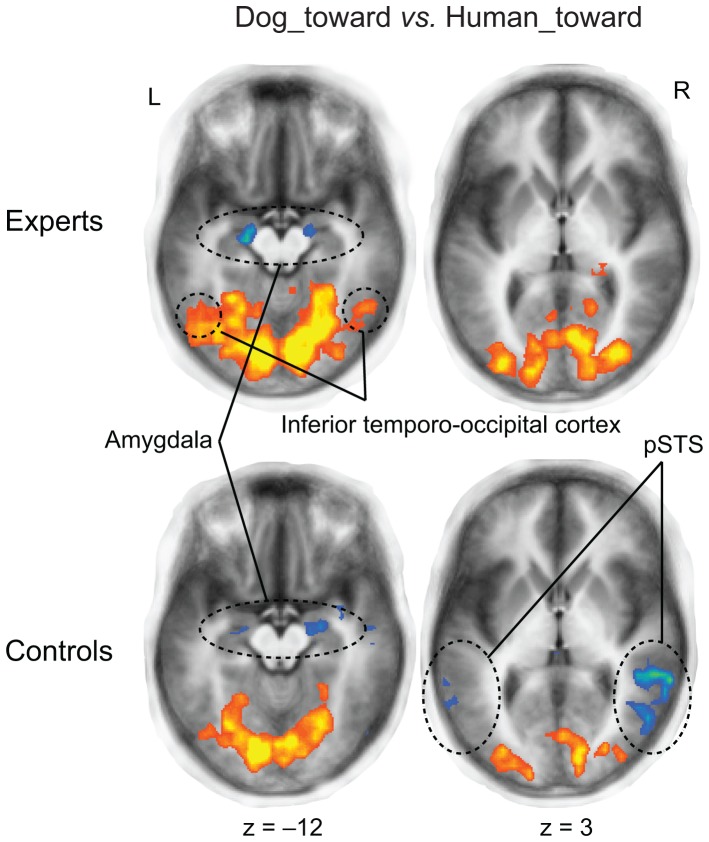
Brain activation to dogs vs. humans facing a conspecific.Differences in brain activation between Dog_toward and Human_toward at q (FDR)<0.05. Activation was stronger to Human_toward than Dog_toward in the amygdala of both groups (left panel), and in the pSTS of control subjects only (bottom right). Activation to Dog_toward was stronger than to Human_toward in the inferior temporo-occipital cortex of dog experts (top left). Smaller cluster size of k = 3 is used here to visualize the bilaterality of amygdala activation. Stronger activation to Dog_toward than Human_toward is depicted in blue color, and stronger activation to Human_toward than Dog_toward is depicted in red-yellow color.